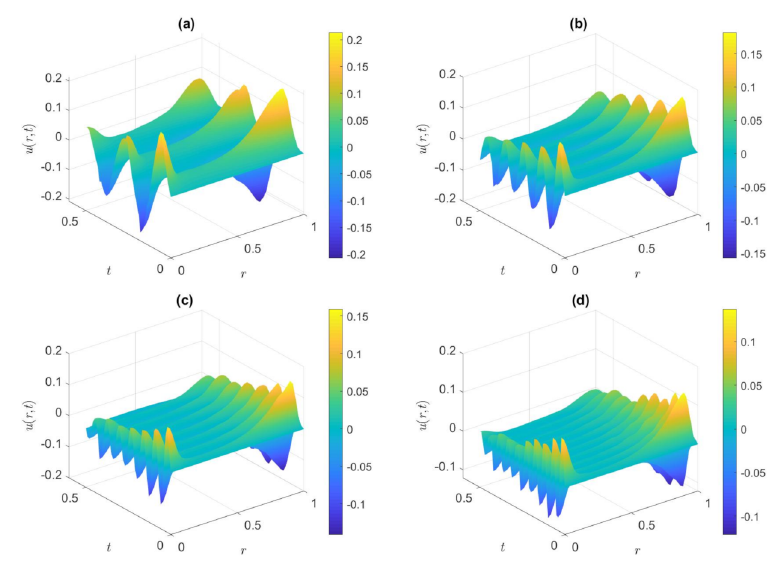
Figure 4. Dimensionless axial velocity variation of the triangular waveform in the microctube at